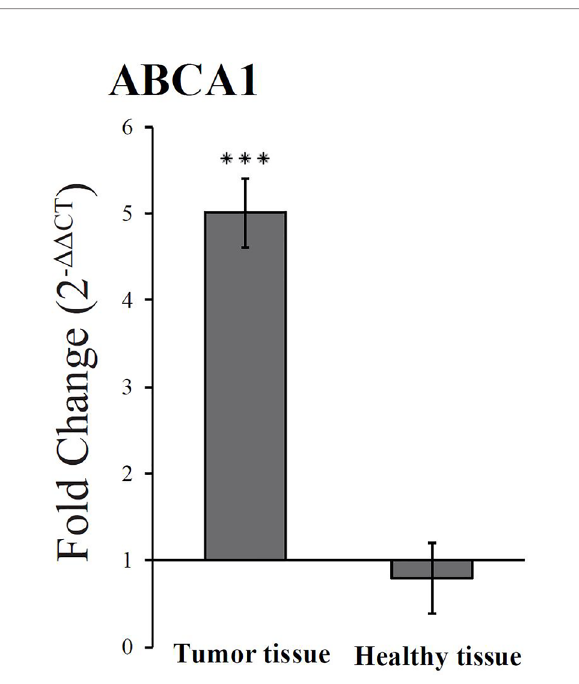
FIGURE 5 | White light microscopy analysis of lipid droplets (LDs) in cells. The amount of lipid droplets increases signi fi cantly with treatment of 5 m M falcarindiol (FaDOH). (A) Representative white light microscopy image of human mesenchymal stem cell (hMSC) treated with 5 m M FaDOH (24 h) with which LDs can be visualized. (B) Representative white light microscopy images of LDs in untreated (24 h) hMSC. (C) LD count of the white light microscopy images. Bar graph represent mean ± SD. LDs were counted in 50 cells in different images for each set of samples. * indicates P < 0.05 in a non-parametric Wilcoxon Rank Sum test. Scale bars are 10 µm.